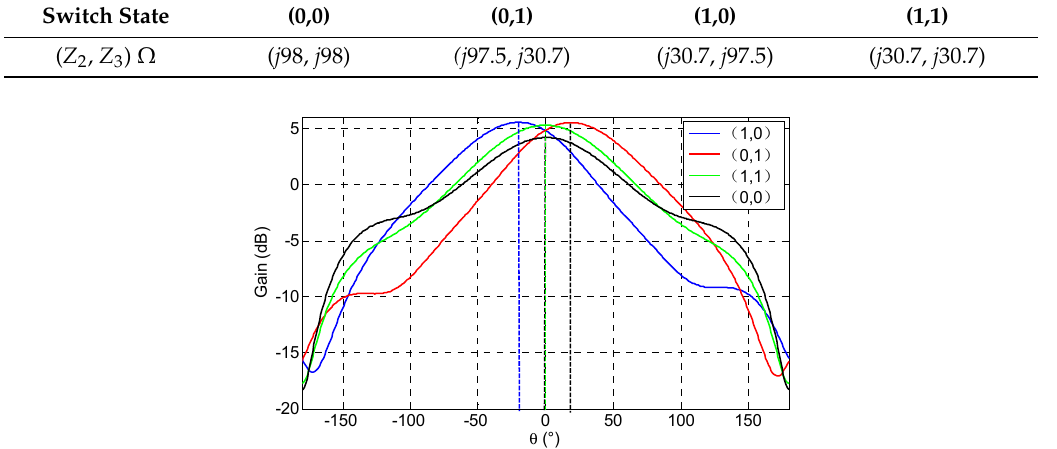
Table 4. The four kinds of combination for driven patch load conditions.